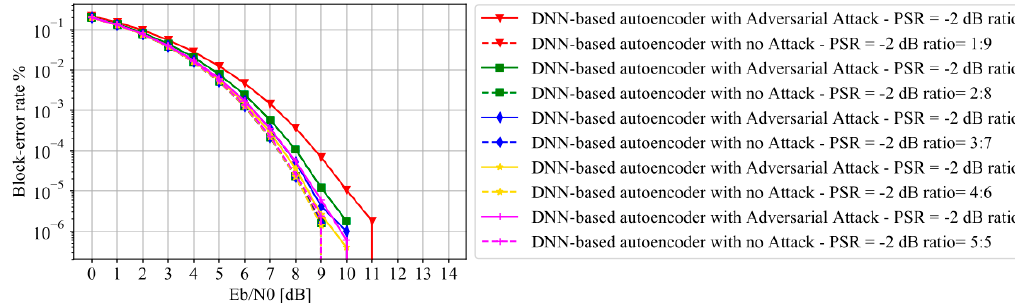
Figure 5. BLER versus E b / N 0 under randomly shifted adversarial attacks when the DNN-based autoencoder is re-trained with different ratios of clean to adversarial examples.